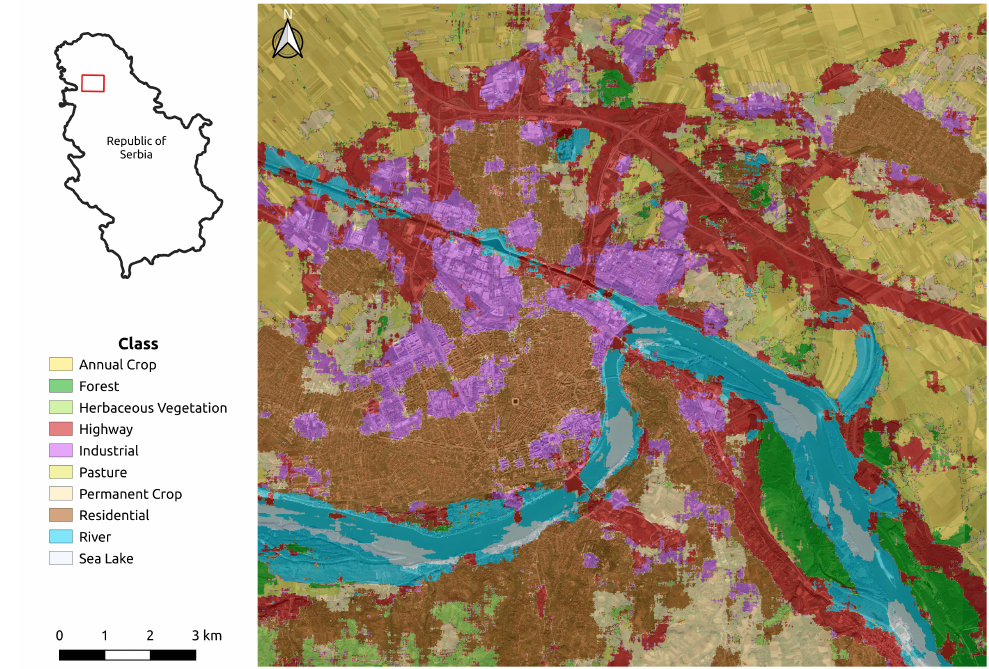
Figure 4. Sample land cover detection